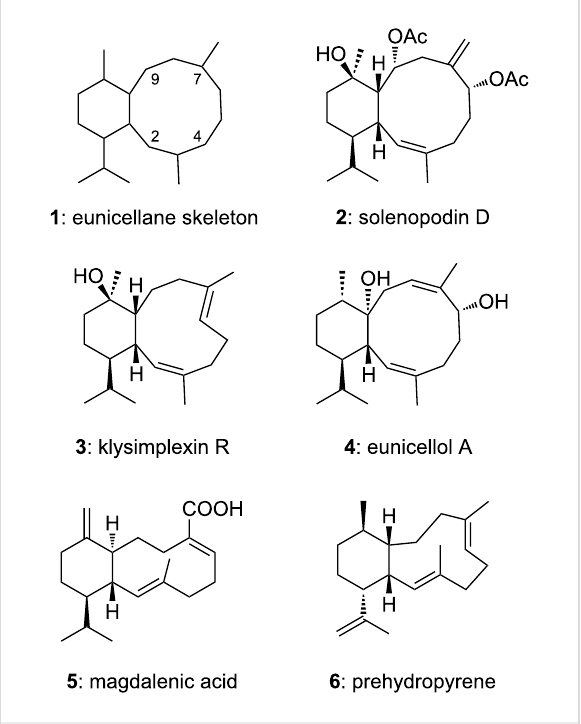
Figure 1: Bicyclic eunicellane-type diterpenes.